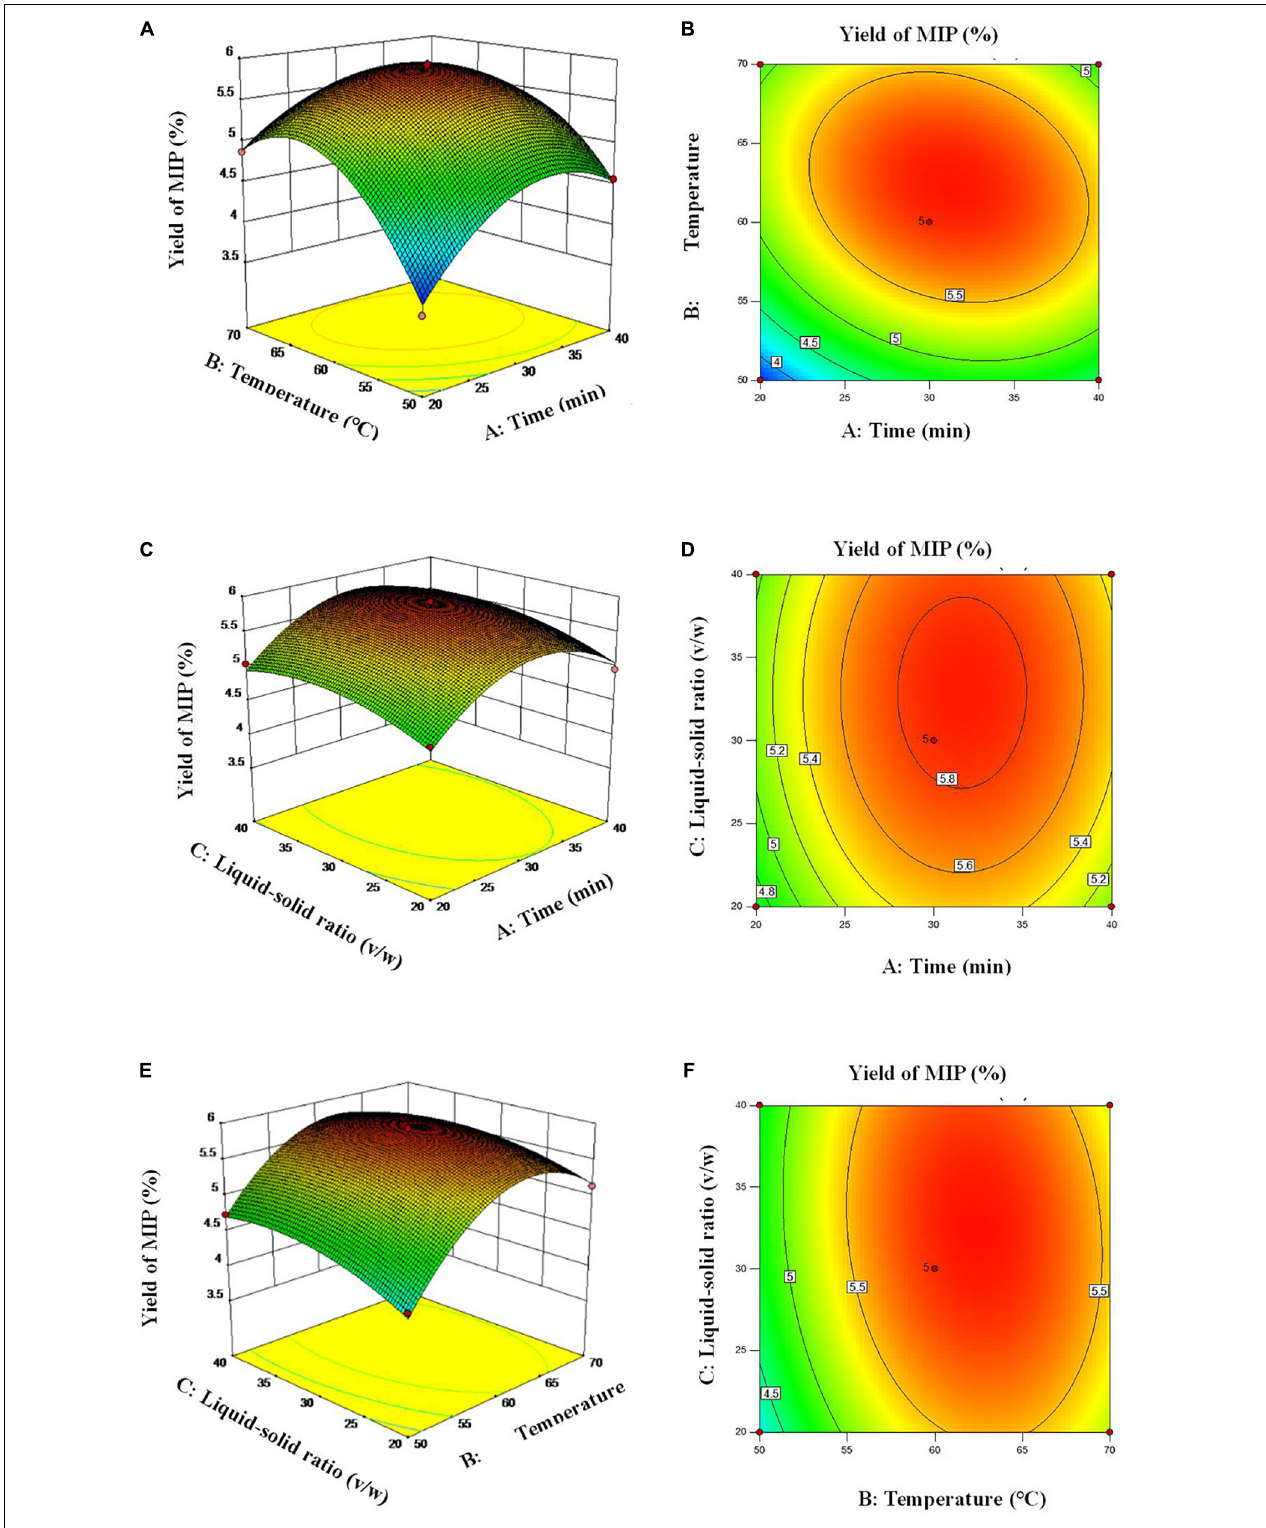
FIGURE 2 | Response surface plots (A,C,E) and response contour plots (B,D,F) showing the extraction time, extraction temperature and Liquid-solid ratio on the extraction yield of MIP.